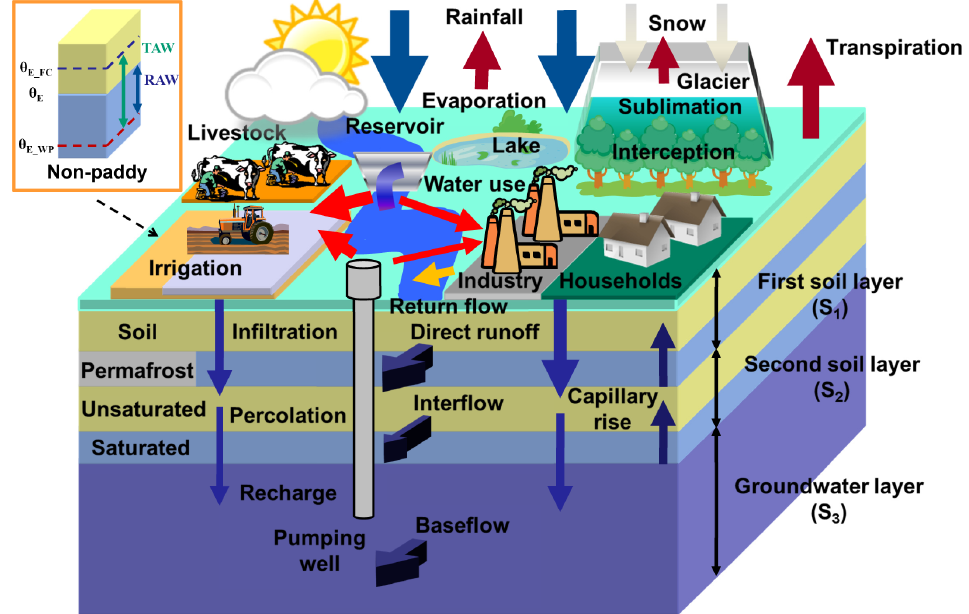
Fig. 1. Schematic diagram of the integrated modeling